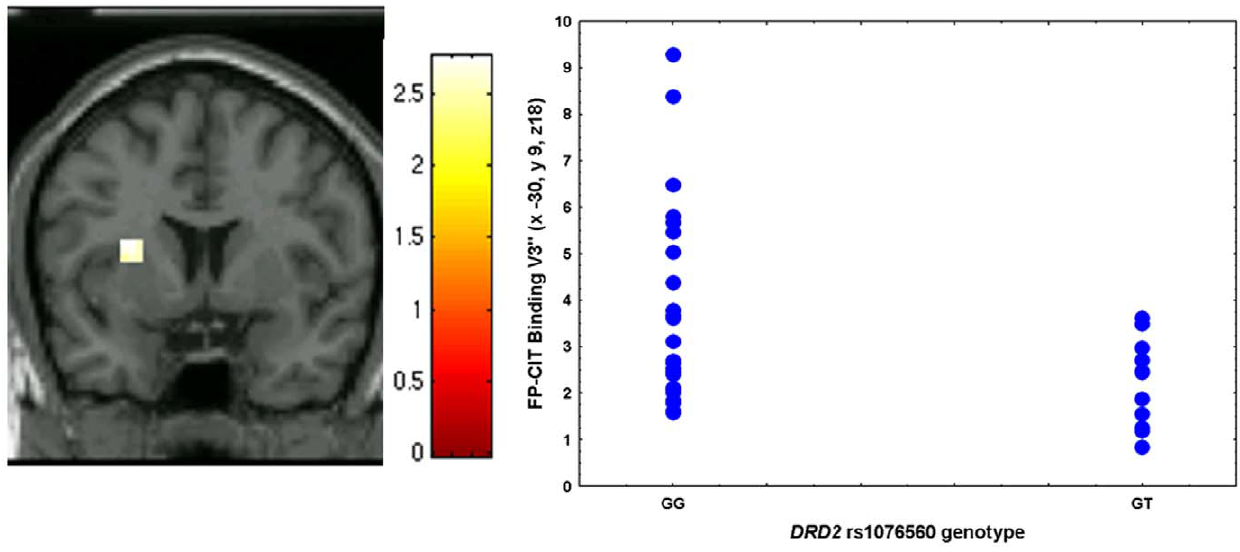
Figure 2. Association between DRD2rs1076560 genotype and [ 123 I]FP-CIT binding. Coronal section of the effect of DRD2 rs1076560 genotype (GG . GT) on [ 123 I]FP-CIT specific binding (V3 0 ) in left putamen (left) and relative scatterplot of individual data points from the cluster differentiating the two groups (right).